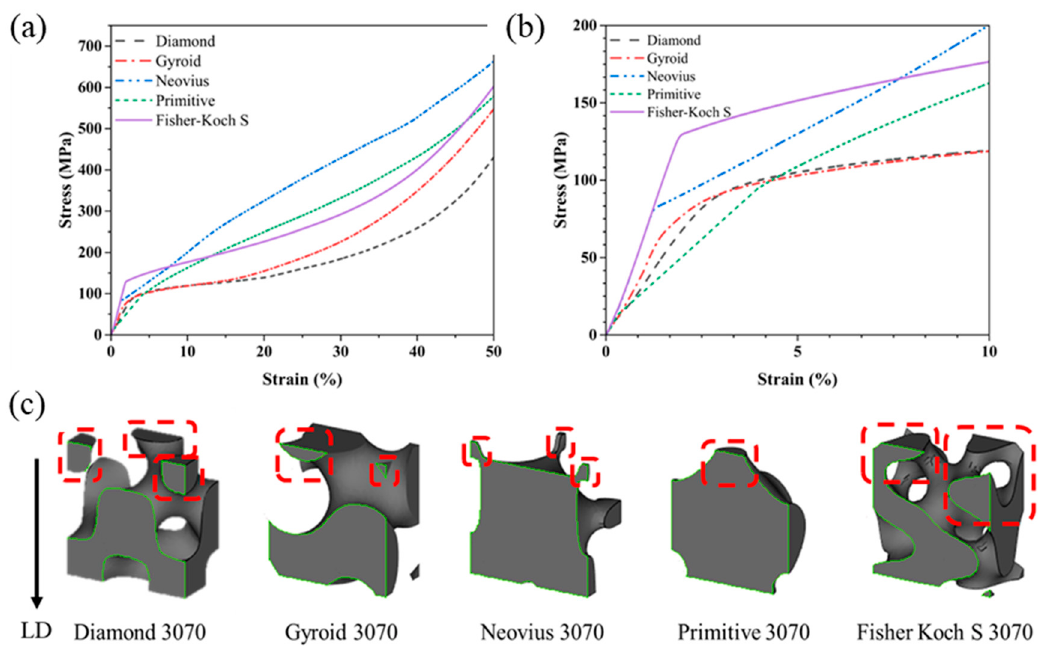
Figure 5. ( a ) Stress–strain curves of the different functionally graded lattice specimens from 0 to 50% strain. ( b ) Stress–strain curve of the fabricated samples with 0 to 10% strain. ( c ) Section views of the unit cells with loading direction (LD).